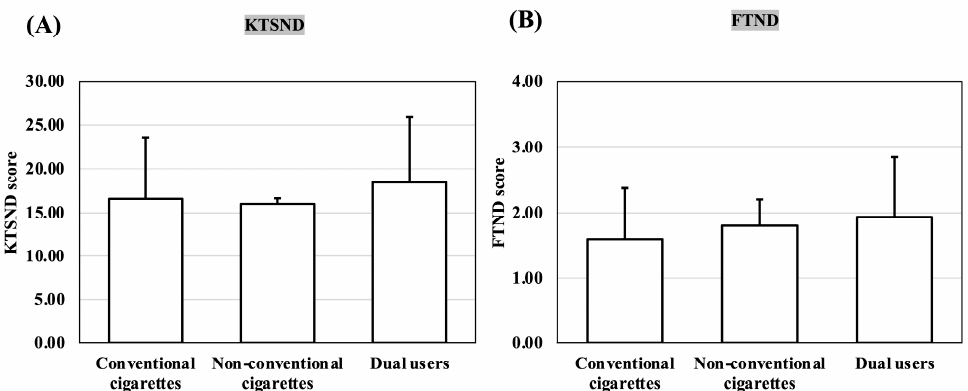
Figure 4. ( A ) Comparison of KTSND scores by smoking device for those unaware that smoking is a risk factor for COVID-19; ( B ) comparison of FTND scores by smoking device for those unaware that smoking is a risk factor for COVID-19. KTSND, Kano Test for Social Nicotine Dependence; FTND, Fagerström Test for Nicotine Dependence, COVID-19, coronavirus disease 2019; conventional cigarettes, cigarettes smokers; non-conventional cigarettes, smokers of heated tobacco products or e-cigarettes; dual users, smokers who use both conventional cigarettes and non-conventional cigarette products.